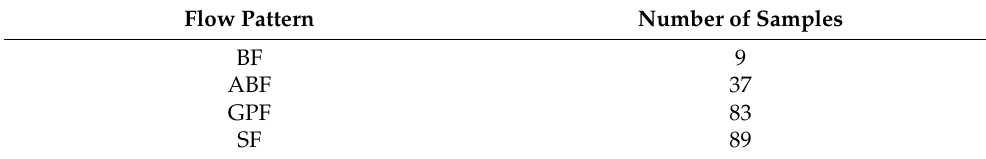
Table 4. Description of experimental data set. Flow